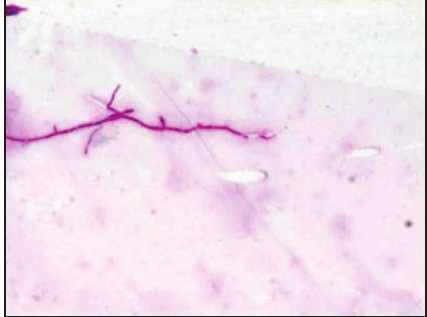
Figure 5: Cloudy swelling, cotton wool spots, and scattered intraretinal haemorrhages.